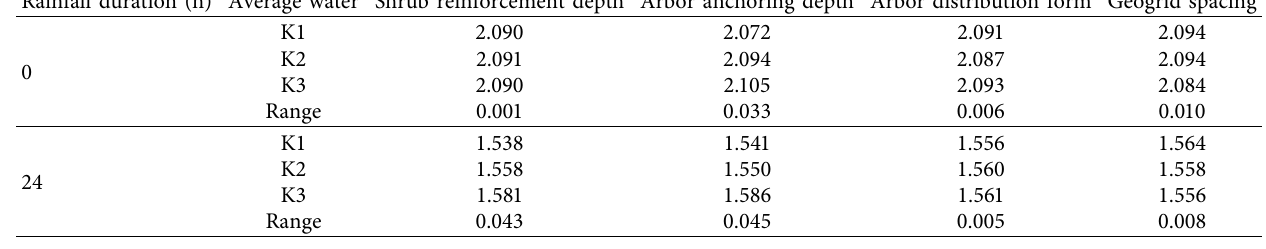
Table 5: Range analysis of the slope safety factor.